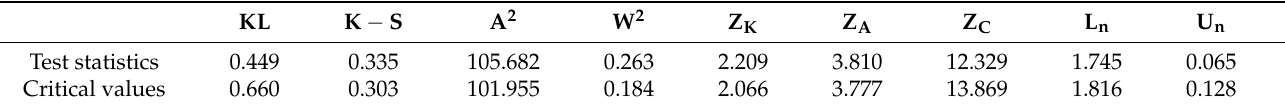
Table 11. Values of different test statistics in